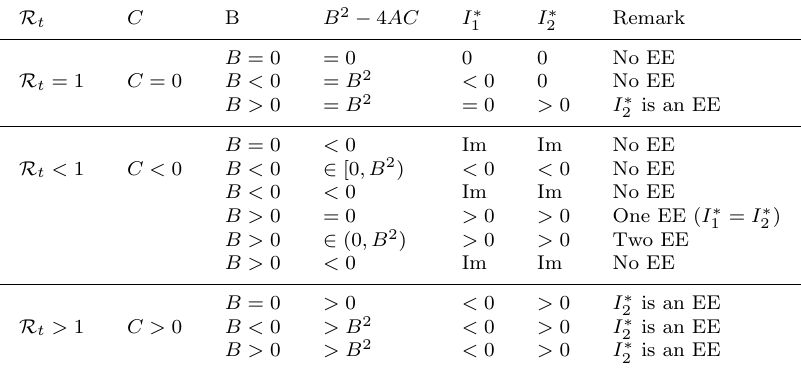
Summary of I ∗ and I ∗ of a CBPP model with antibiotic treatment given by 1 2 (3.1)–(3.6) showing the relation between values of R t and existence of